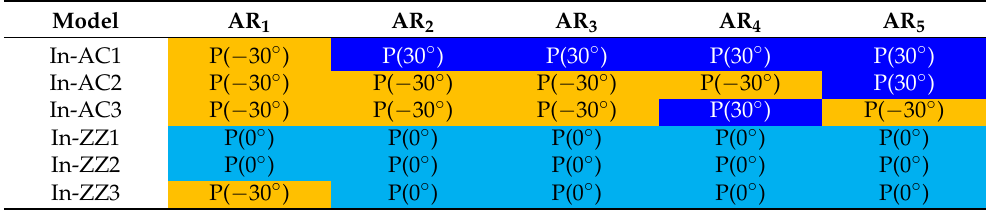
Table 2. Crack propagation paths in the in-plane tearing of graphene sheets with v = 0.4 Å/ps at 1 K.